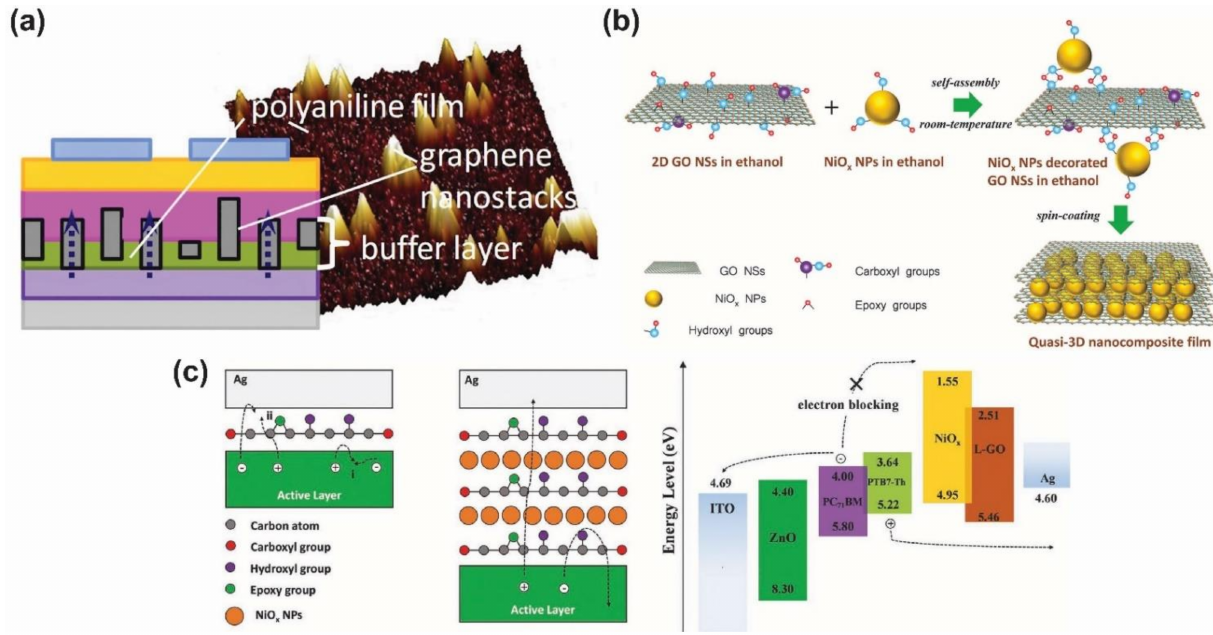
Figure 12. ( a ) Topography AFM-images of G/PANI–PAMPSA nanocomposite layer. Adapted with permission from [243]. Copyright 2018, Elsevier. ( b ) Schematic representation of the preparation at room temperature of self-assembled quasi-3D GO:NiO x nanocomposite and ( c ) hole extraction properties and dynamics at the interface. Adapted with permission from [245]. Copyright 2018, John Wiley and